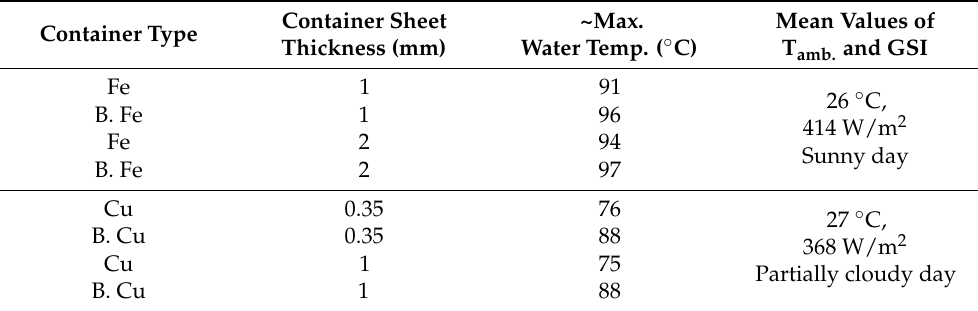
Table 3. The maximum water temperatures, according to the used Fe, B. Fe, Cu, and B. Cu containers, with two thicknesses each, 11/10/2021 and 14/10/2021, respectively, Amman, Jordan. Container Sheet ~Max. Container Type